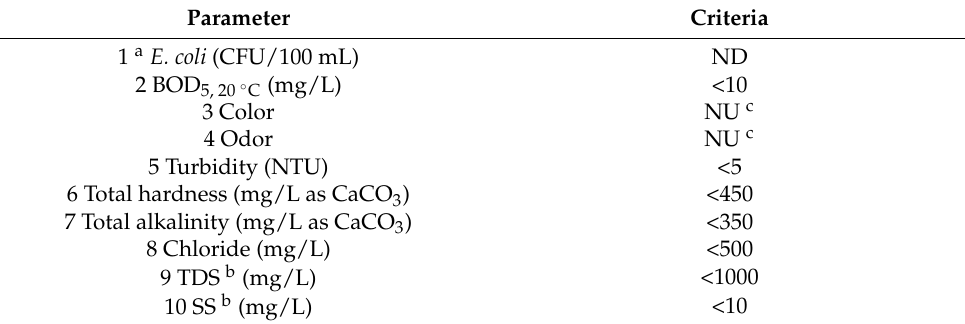
Table 2. Taiwan EPA wastewater reuse criteria